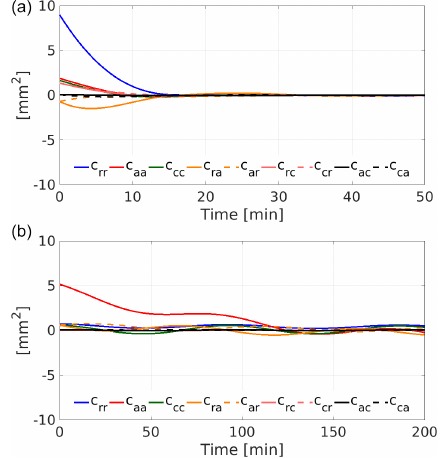
Figure 7. Empirical covariance function derived from the reduced- dynamic orbit residuals (a) and dynamic orbit residuals (b) of GRACE-A over one month for a period of 50 and 200min and in a LOF composed of radial (r), along-track (a) and cross-track (c).